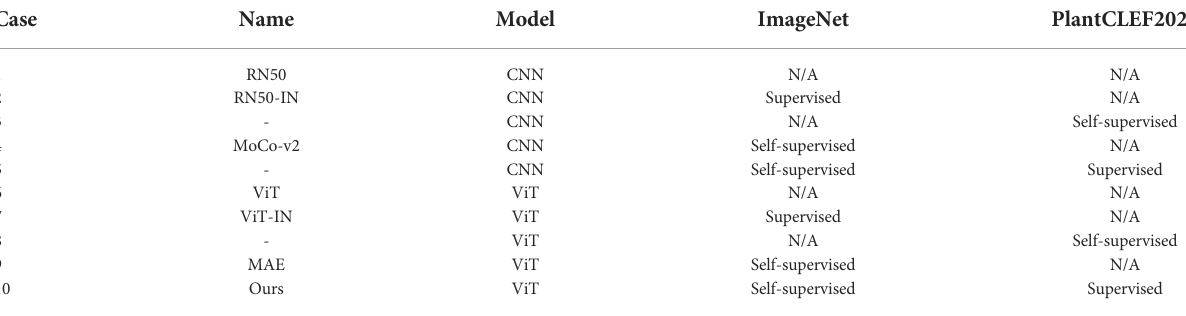
TABLE 3 The characteristics of the compared methods.